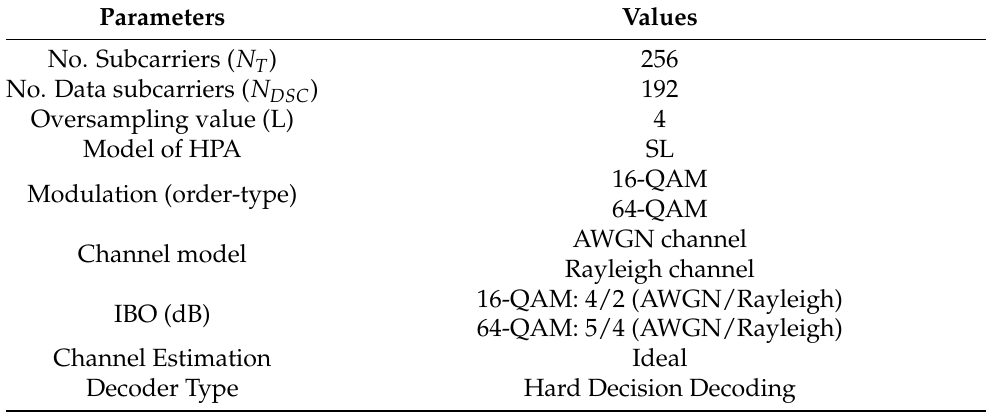
Table 1. List of simulation parameters.